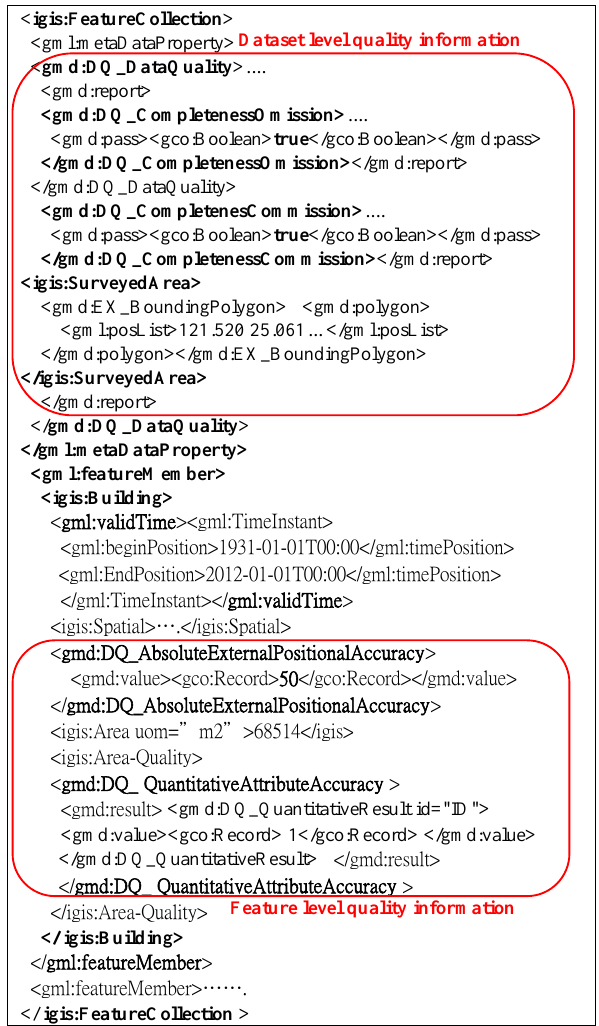
Figure 2. Example of “building” dataset